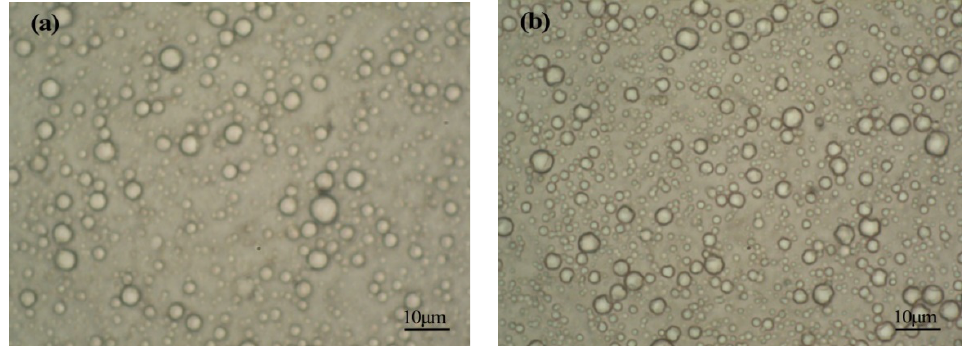
Figure 7. The optical microscope morphology of the prepared MicroPCMs at the emulsification stirring speed of ( a ) 5000 rpm and ( b ) 6000 rpm.